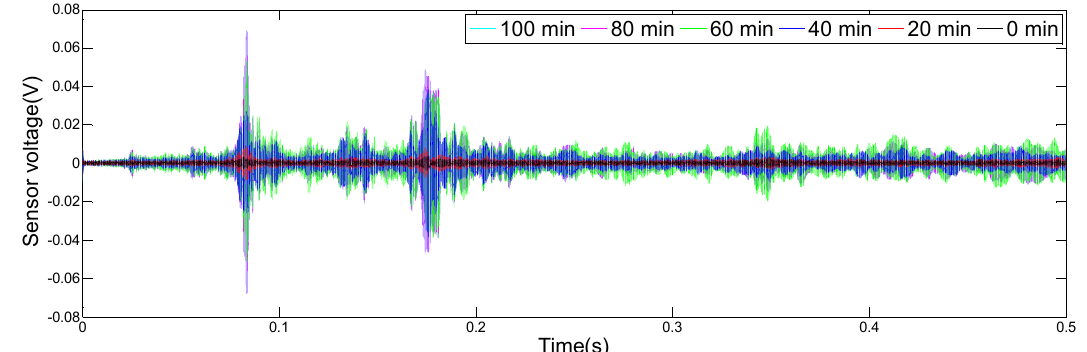
Figure 9. Signal received by PZT2 (0–100 min).